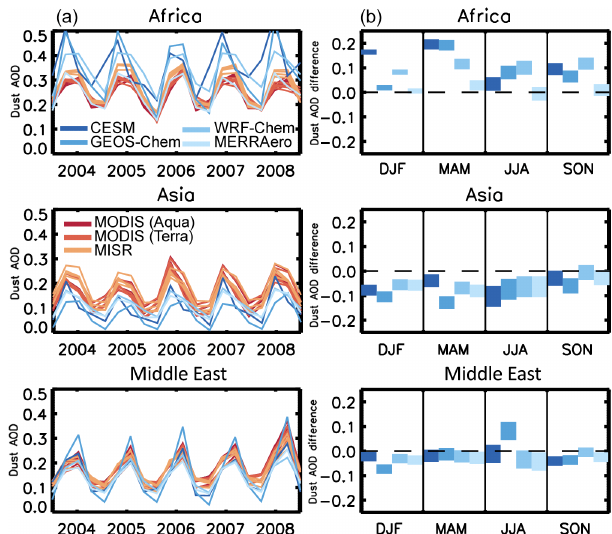
Figure 7. (a) Seasonal dust AOD between 2004 and 2008 for observational-based estimates (red hues; each of the 12 lines repre- sents a different ensemble member) and for the models (blue hues). (b) To isolate the seasonality, the difference between model and observational-based seasonal dust AOD, averaged over 2004–2008, is shown. Bar thickness indicates the range of the observational- based estimates for each season; the deviation from zero (dashed line) indicates the bias in model seasonal dust AOD relative to the observations. The regions are based on area-weighted averages over the subset of regions defined in Fig. 1, except Africa, which does not include the mid-Atlantic region (shown separately in Figs. 8 and 9 with other